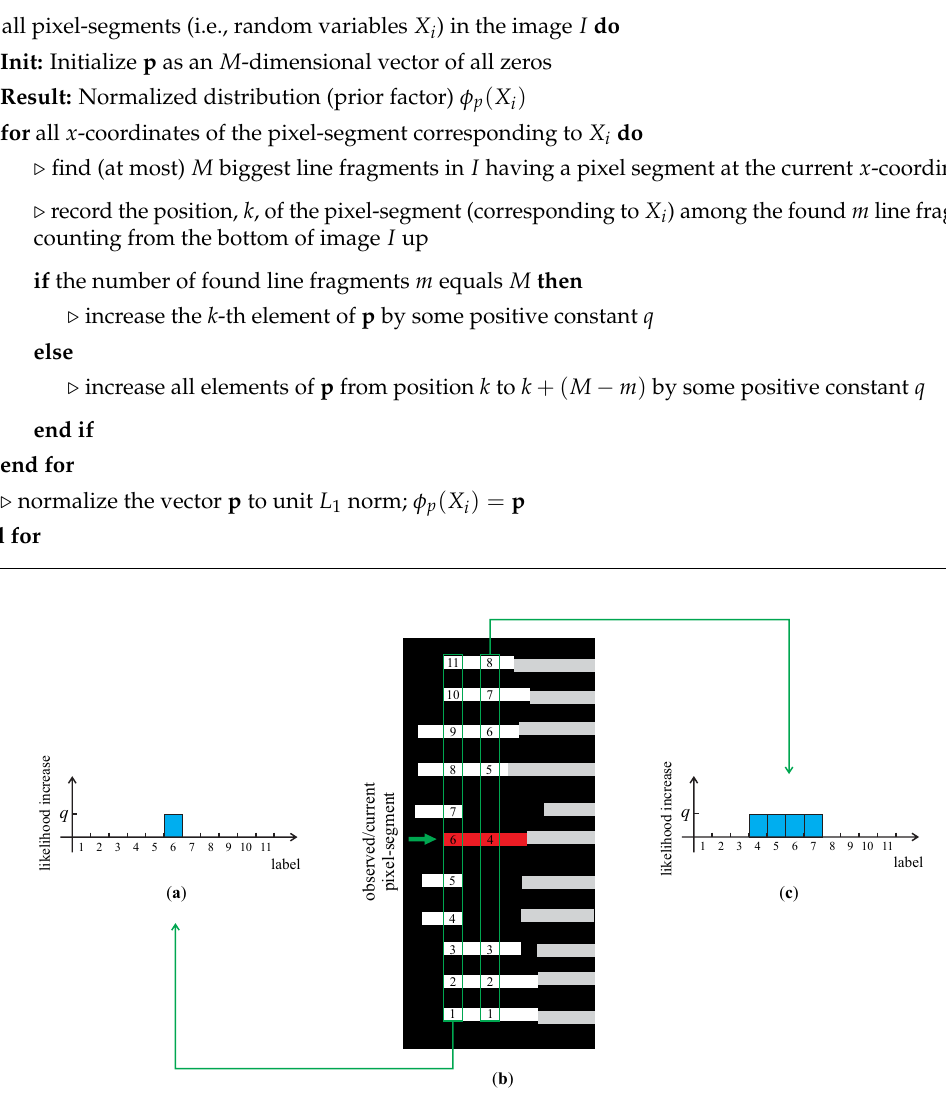
Figure 7. Computing prior factors: illustration of the procedure with a simple example (shown in ( b )). For each random variable, the prior factor represents a probability distribution over all light-plane labels. Estimates of the probabilities are obtained by labeling the pixel segments and increasing the likelihood (shown in ( a ) and ( c )) of the label assigned to the observed pixel segment at each x